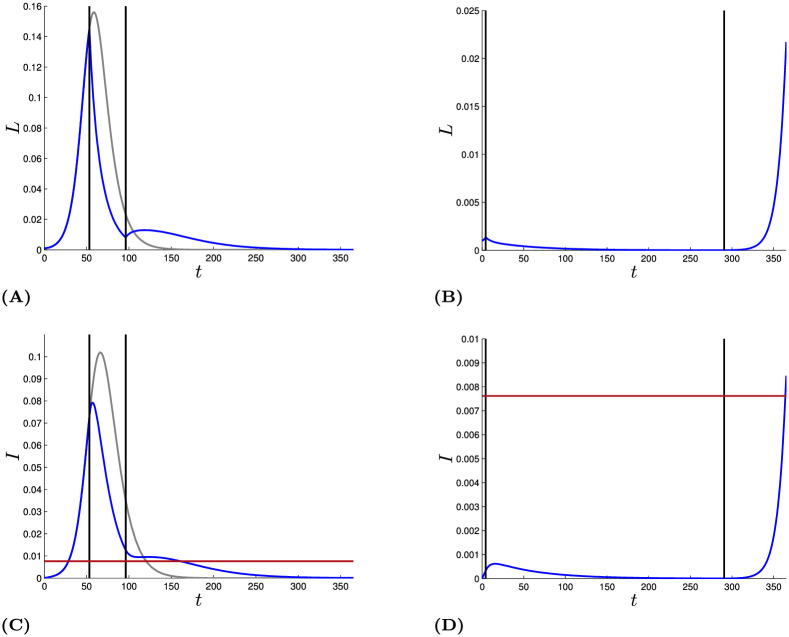
Panel (A) and (B) show the two different solutions paths emerging from the Skiba point for the number of latent L(⋅) (blue lines) and panel (C) and (D) show those paths for the number of infected I(⋅).The gray line in panels (A) and (C) depicts the uncontrolled path without lockdown for comparison. For the total costs and its shares see Table 2. The horizontal red line shows the health care capacity Hmax/p.